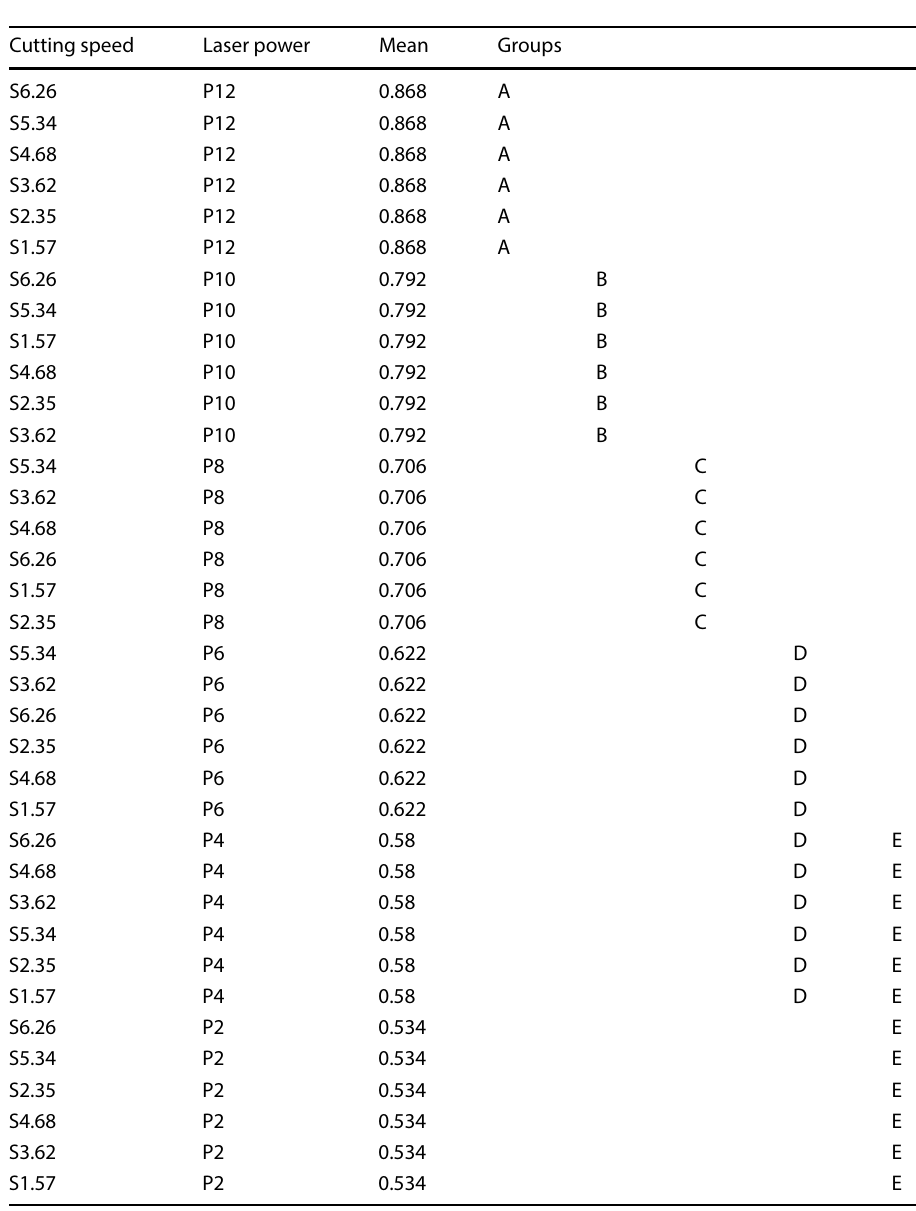
Table 33 Cutting speed & laser power